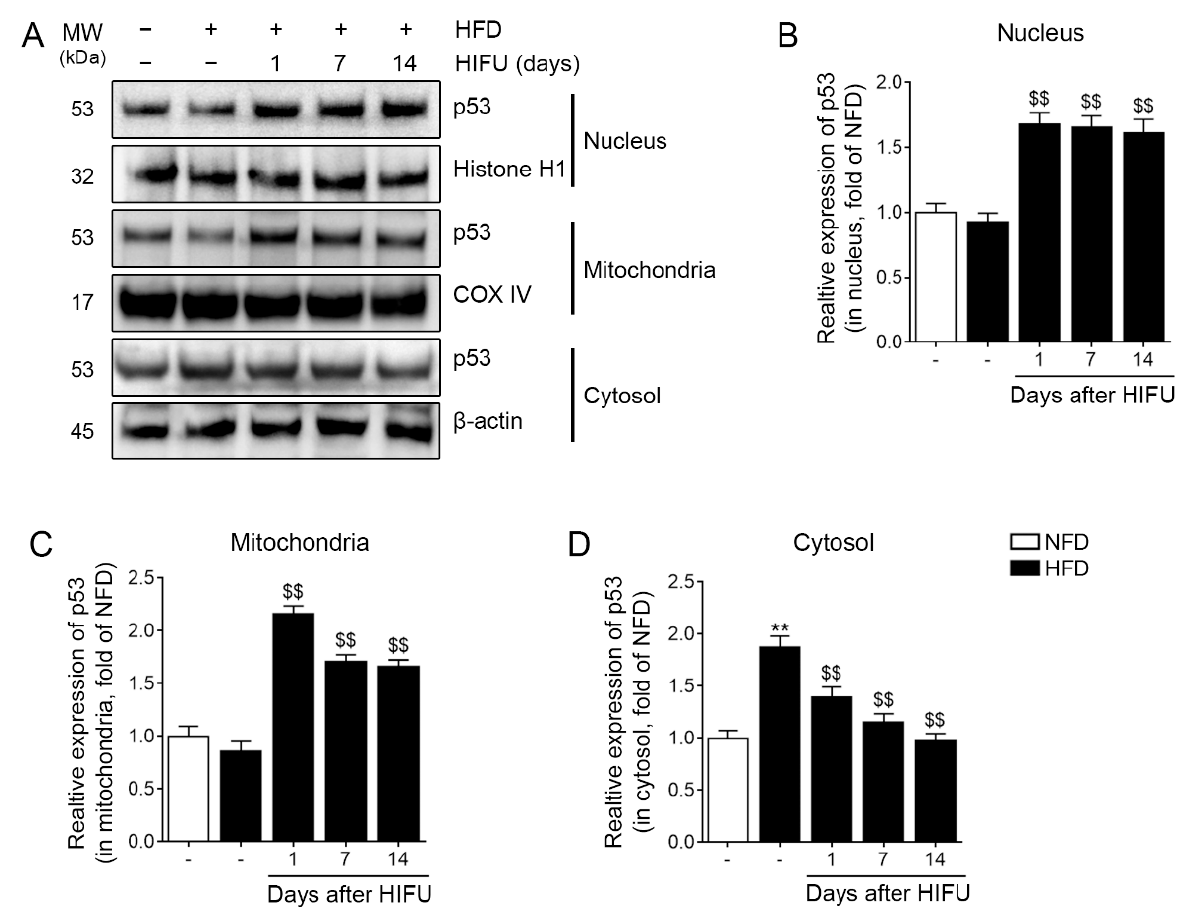
Figure 2. Regulation of nuclear, mitochondrial, and cytoplasmic p53 in SAT by HIFU treatment. ( A ) The protein expression levels of nuclear, mitochondrial, and cytoplasmic p53 were analyzed by western blot. ( B – D ) The quantitative graphs represent the results of the western blot analysis. The protein expression of nuclear p53 ( B ) and mitochondrial p53 ( C ) was increased by HIFU treatment. The protein expression of cytoplasmic p53 ( D ) was decreased by HIFU treatment. The data are presented as the mean ± standard deviation; **, p < 0.01 HFD vs. NFD; $$, p < 0.01 vs. HFD (Mann– Whitney U test). COX IV, cytochrome c oxidase subunit 4; HFD, high-fat diet; HIFU, high-intensity focused ultrasound; NFD, normal-fat diet; SAT, subcutaneous adipose tissue.